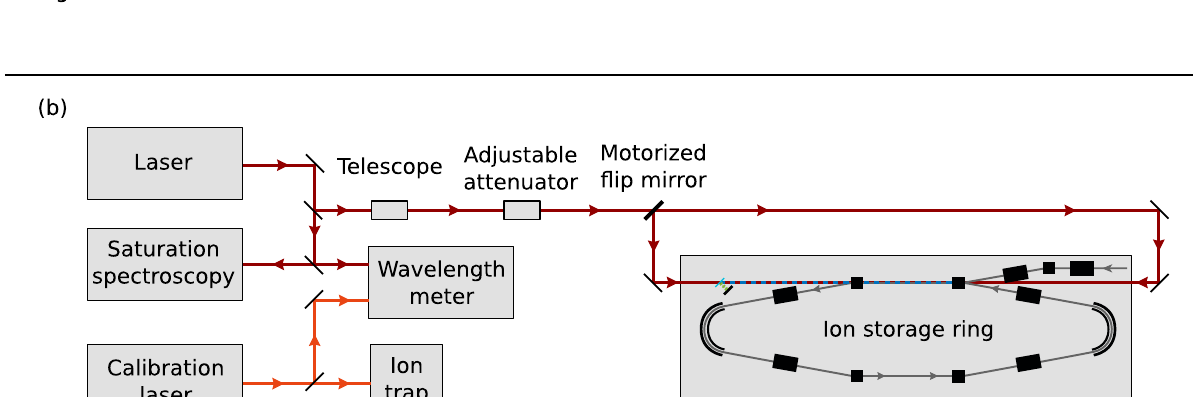
In b theopticalsetupwiththelaser,calibrationlaser,wavelengthmeter,attenuator, fl ip mirror, and overlap with the ion beam is shown. A small fraction of the laser light usedforphotodetachment is picked offby a glass plate in the beam path and guided to the wavelength meter to measure the photon energy continuously dur- ing the measurement